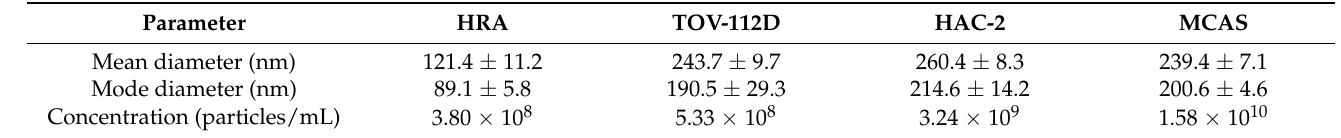
Table 1. Concentration and diameter of extracellular vesicles isolated from culture media of ovarian cancer cell